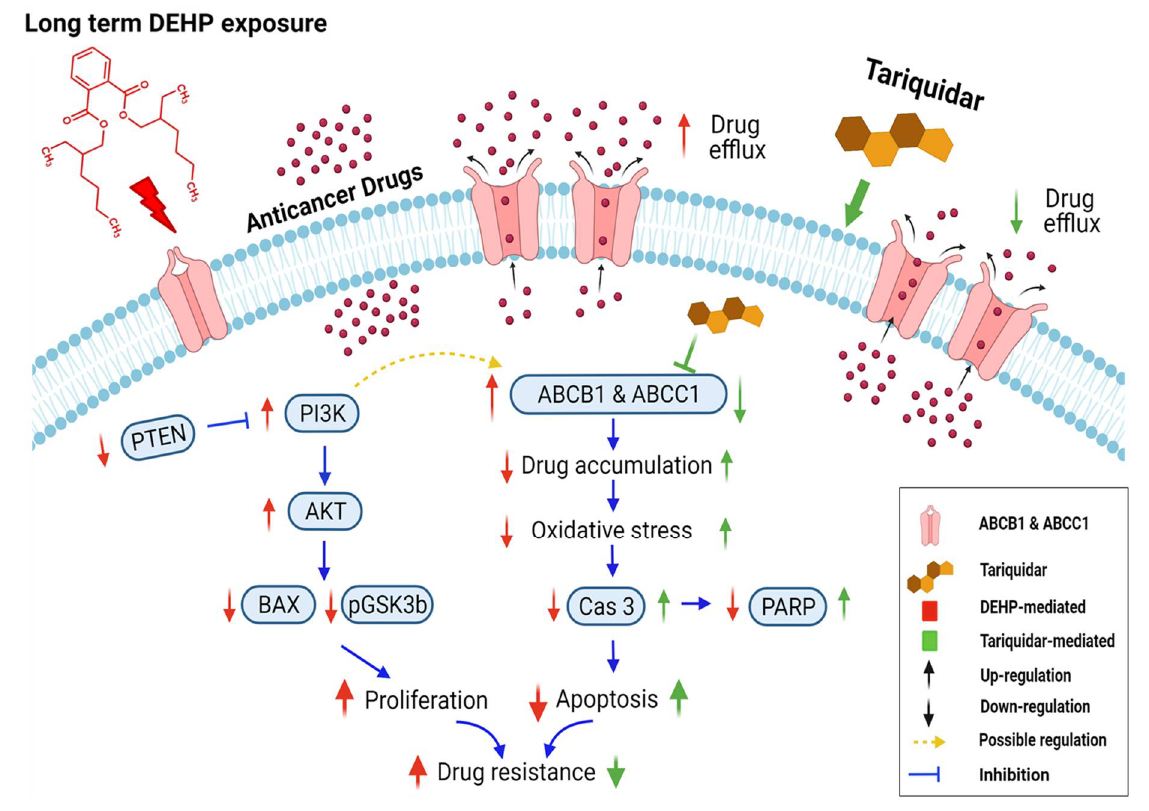
Figure 9. Schematic representation of DEHP-induced acquired drug resistance through MDR1/ABCB1 and MRP1/ABCC1 upregulation in triple-negative breast cancer. Long-term DEHP exposure upregulates MDR1/ABCB1 and MRP1/ABCC1 membrane transporter proteins, increasing drug efflux and decreasing drug accumulation in cells, resulting in acquired multidrug resistance. Long-term DEHP exposure also activates PI3K/Akt signaling, increasing cell survival and proliferation, and it may be involved in the upregulation of ABCB1 and ABCC1. In contrast, tariquidar treatment inhibits the expression of MDR1/ABCB1 and MRP1/ABCC1, decreasing drug efflux, increasing drug accumulation and reversing DEHP-induced acquired multidrug resistance in ER-negative breast cancer cells. → indicate DEHP exposure mediated effect, → indicate tariquidar treatment mediated effect, → indicated interdependent signaling cascade. Created with BioRender.com